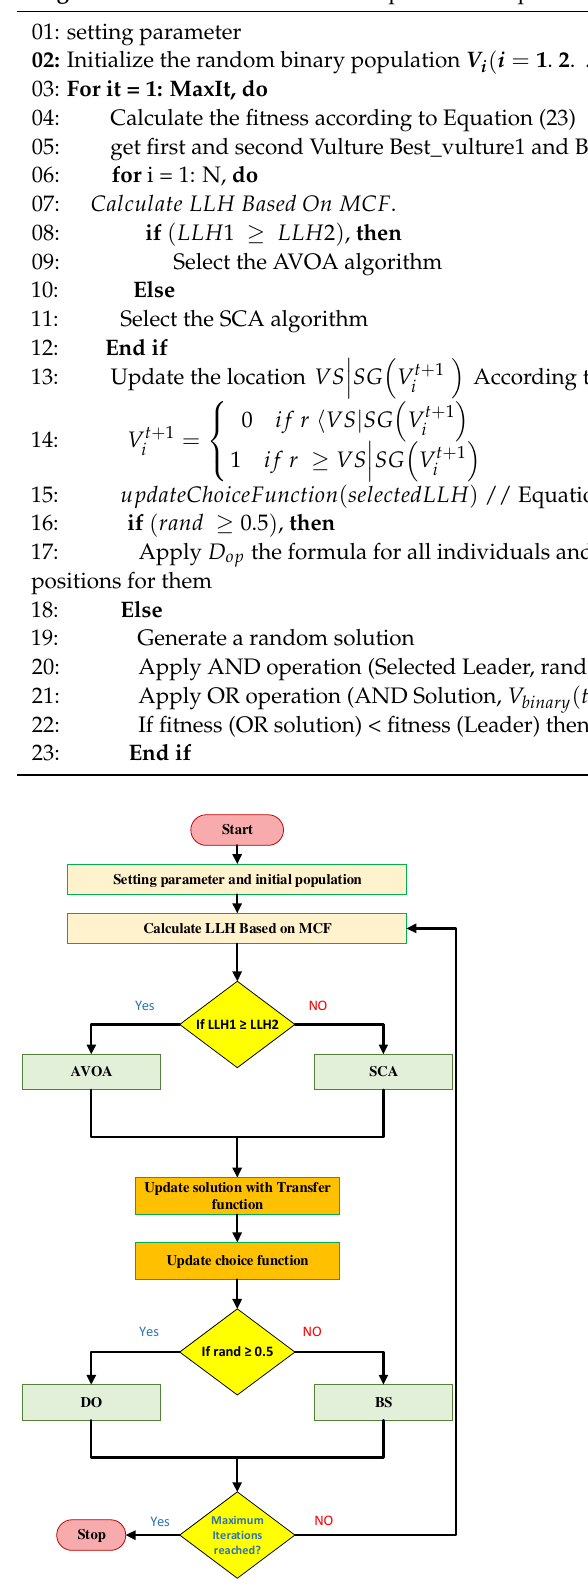
Figure 5. Flowchart of the proposed BAOVAH